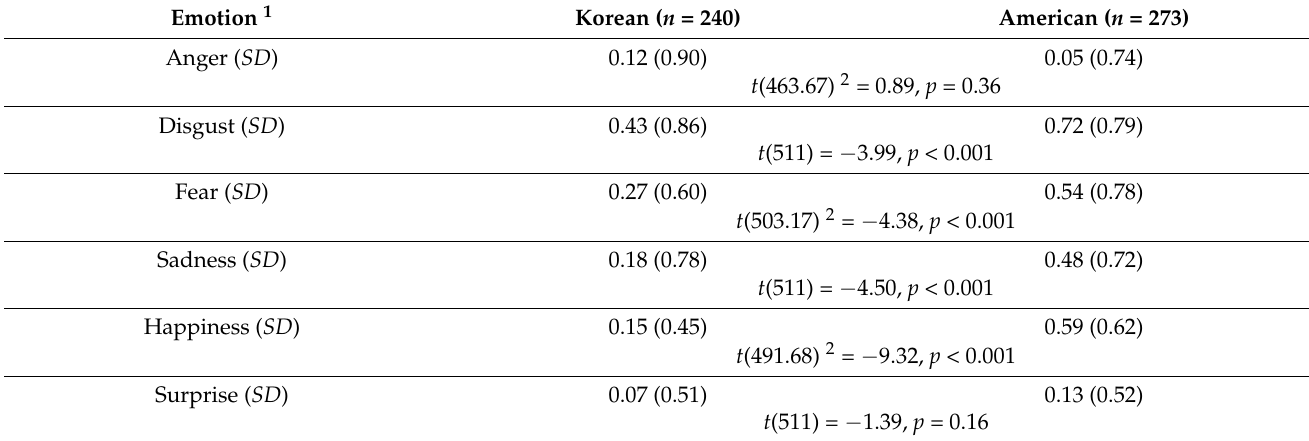
Table 5. Investigation of participants’ nationality-related difference in accuracy difference